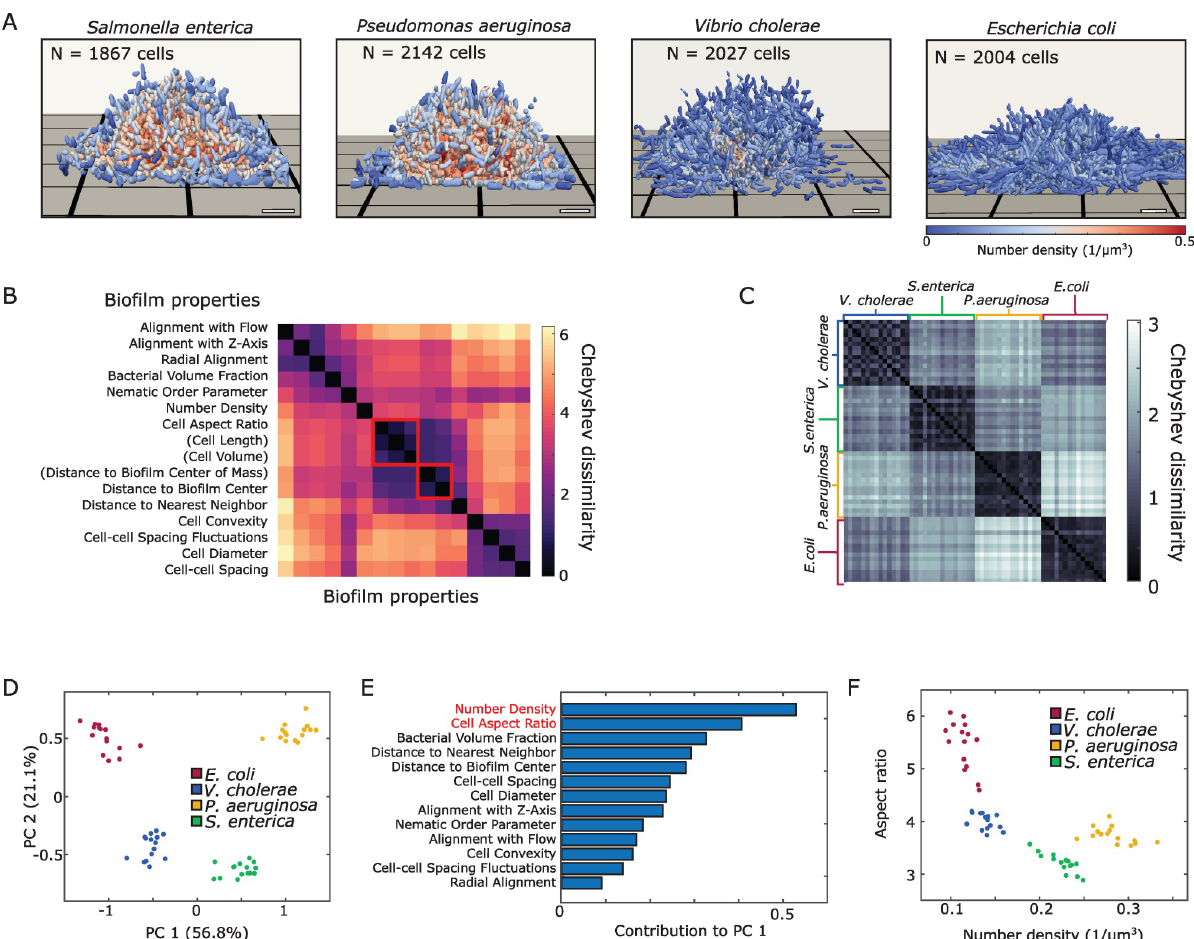
Fig 1. Early-stage biofilm architectures of different bacterial species can be quantitatively distinguished within a two-dimensional phase diagram derived from a statistical analysis of architectural properties. ( A ) Representative 3D biofilm microcolony architectures of 4 bacterial species reconstructed from segmented confocal microscopy images at comparable cell numbers (approximately 2,000 cells). Each cell is colored according to the local density within its neighborhood, of radius 2 μ m. Scale bars, 5 μ m. ( B ) For each biofilm, we approximated the distributions of 16 measured properties with Chebyshev polynomials (Section C in S1 Text). Using the Chebyshev polynomials for each measured property, a Cd measure is defined (Section C in S1 Text). Using this measure, highly correlated properties are identified and reduced as indicated by red squares, leaving p = 13 relevant properties. ( C ) The Cd also provides a robust and quantitative comparison of biofilm architectures from different species, as indicated by the block structure in this diagram. ( D ) PCA based on the Chebyshev coefficient space (Section C in S1 Text) robustly distinguishes biofilms of the 4 different species, E . coli , V . cholerae , P . aeruginosa , and S . enterica . ( E ) Cell aspect ratio and local number of neighbors are the key contributors to the first principal component (Section C, Fig D in S1 Text). ( F ) Representing the experimental data in the mean aspect ratio vs. cell number density plane confirms that these 2 properties define a biophysically interpretable phase diagram to categorize biofilm architectures. Source data are available at DOI: 10.5281/zenodo.7077624. Cd, Chebyshev dissimilarity; PCA, principal component analysis; 3D,